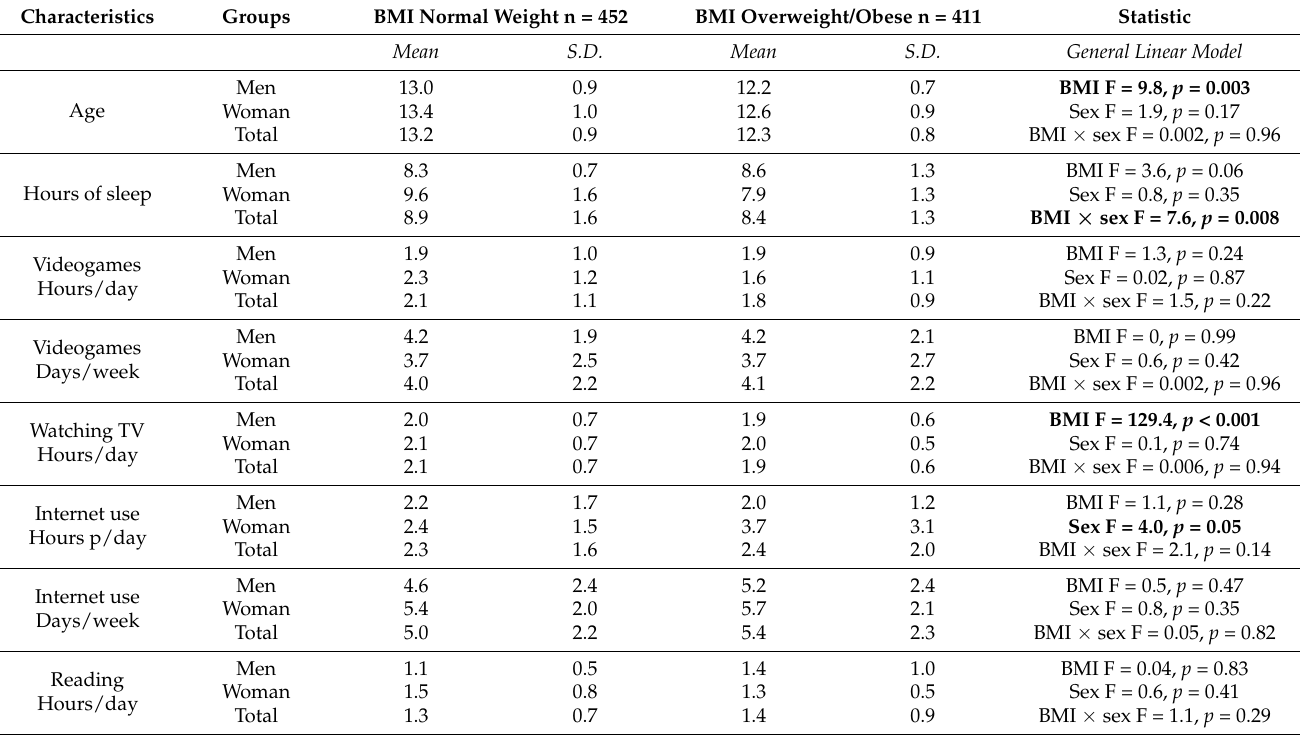
Table 2. General linear models of the association between hours of sleep, as well as sedentary and physical activities, and obesity in Mexican